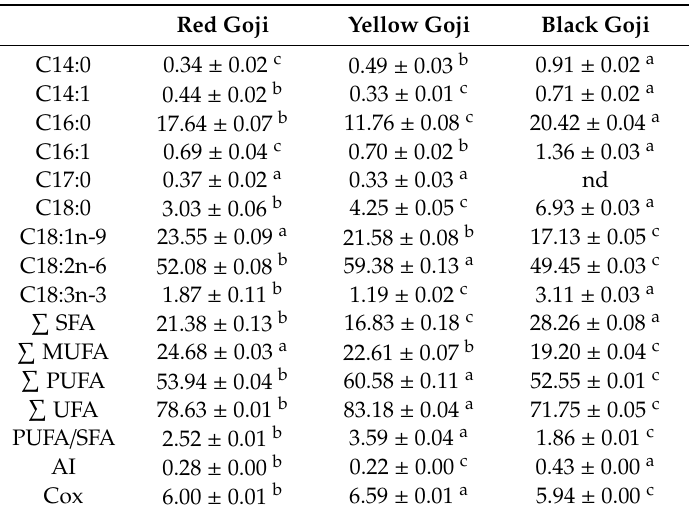
5.94 ± 0.00 c nd-not detected; myristic acid (C14:0); myristoleic acid (C14:1); palmitic acid (C16:0); palmitoleic acid (C16:1); heptadecanoic acid (C17:0); stearic acid (C18:0); oleic acid (C18:1n9); linoleic acid (C18:2n6); linolenic acid (C18:3n3); SFA—saturated fatty acids; MUFA—monounsaturated fatty acids; PUFA—polyunsaturated fatty acids; UFA—unsaturated fatty acids; AI—atherogenic index; Cox—oxidisability value; di ff erent letters in the same